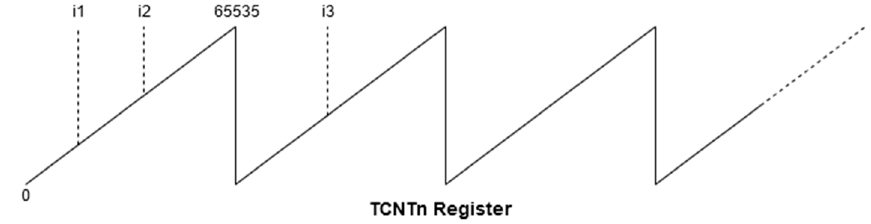
Figure 7. Timer’s working principle.